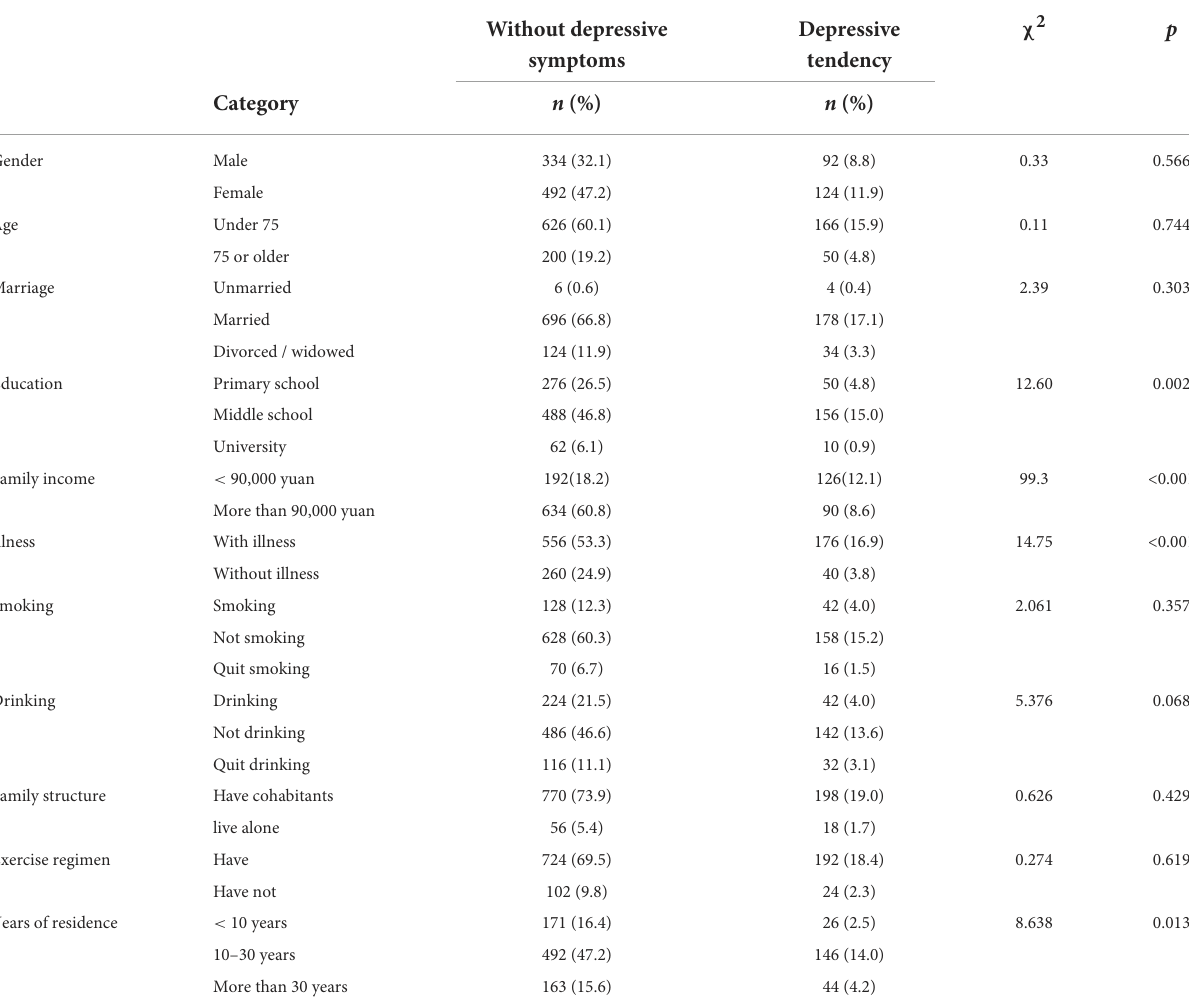
TABLE 3 Comparison of depressive situations.